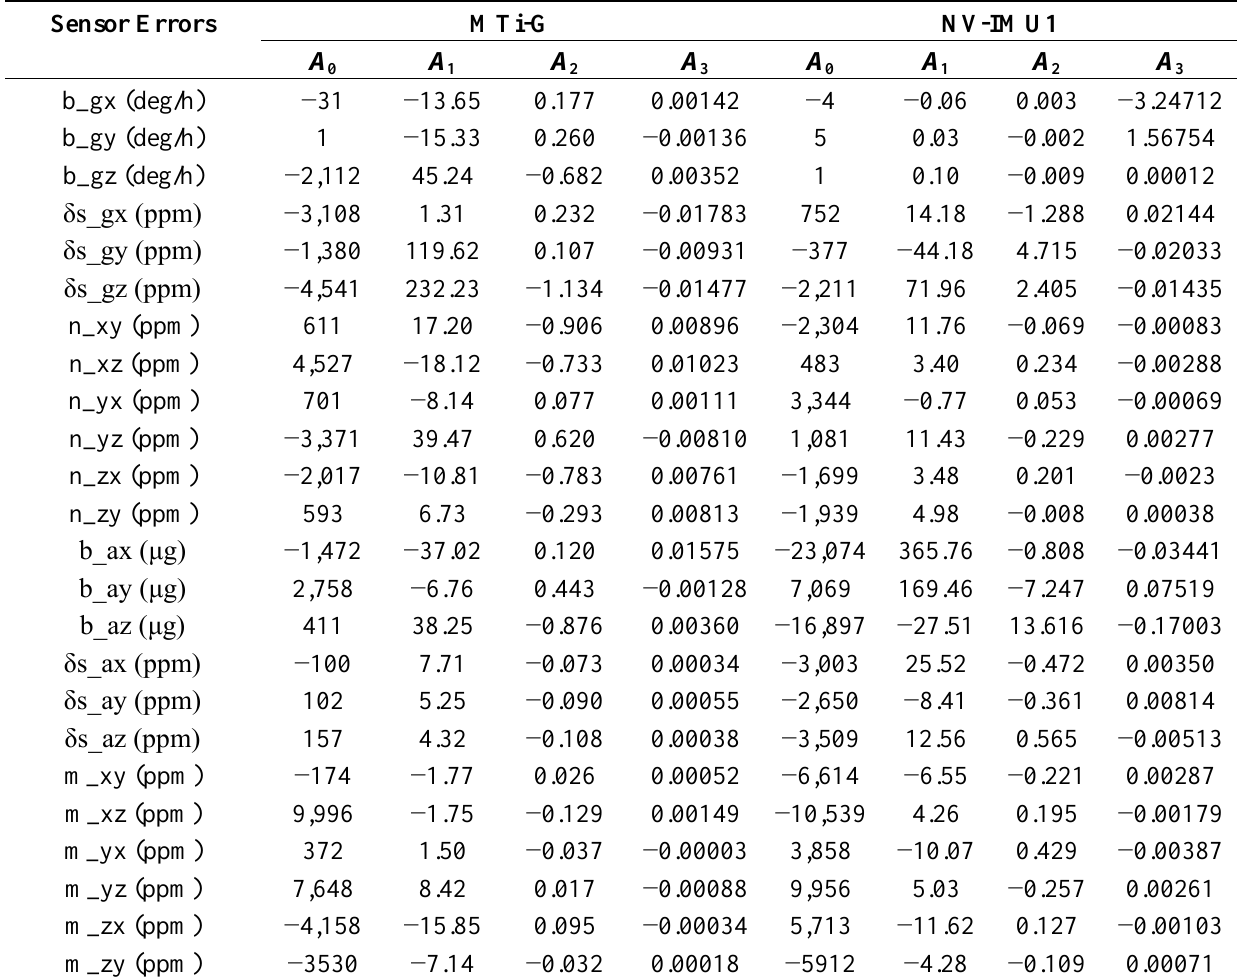
Table 9. The parameters of the 3rd order polynomial thermal models of the IMU errors applied in the thermal compensation tests, i.e. , A thermal models can be used to calculate the thermal drifts of the IMU sensor errors at each temperature and then remove such thermal drifts from the IMU